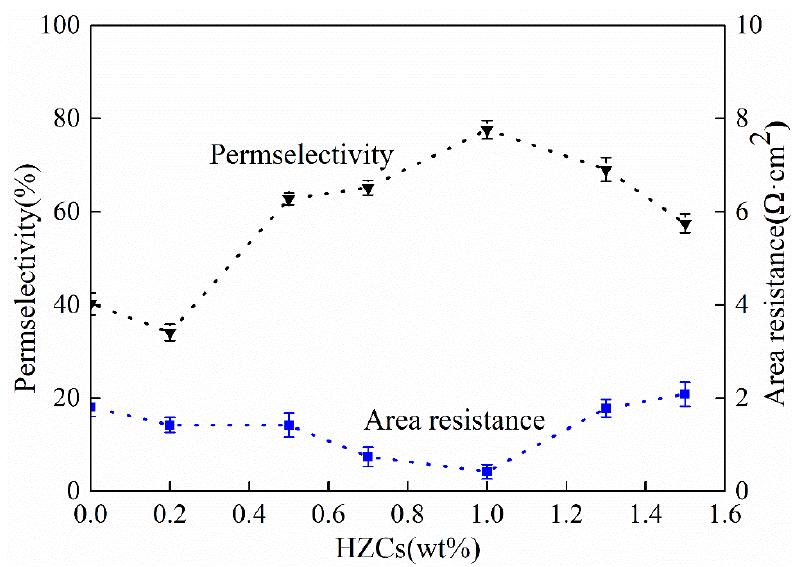
Figure 9. Effect of HZCs loading on the permselectivity and area resistance of the nanocomposite membrane.